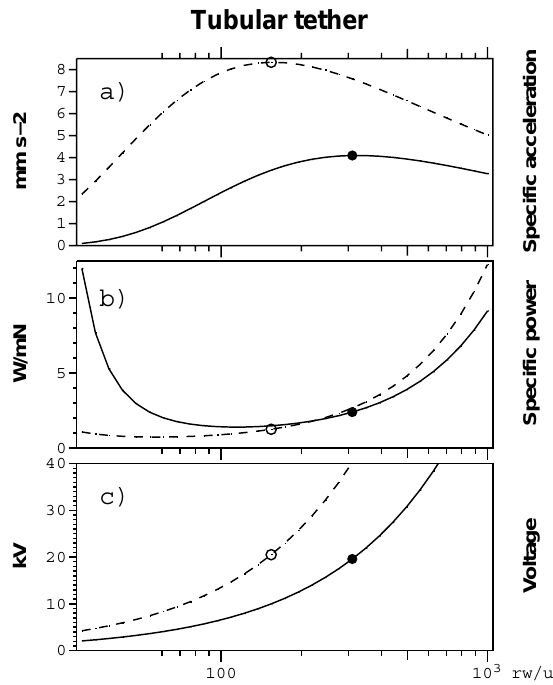
Fig. 3. Specific acceleration (a) , specific power consumption (b) and voltage (c) of a tubular, negatively charged aluminium tether with 10 µ m wall thickness. The logarithmic horizontal axis is the radius r w of the tether in micrometres. Solid curves correspond to allowed surface electric field E 0 = 5MV/m and dashed curves to E 0 = 10MV/m. Points of maximum specific acceleration are marked on the